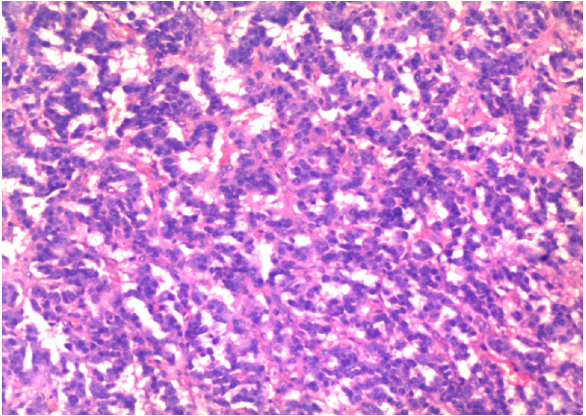
Figure 3. Histopathological (H&E) image of glucagonoma. The pathological examination of excised tissue showed a grade 2 pancreatic neuroendocrine tumor, with a mitotic count of 3 per 10 high-power fields (× 100).